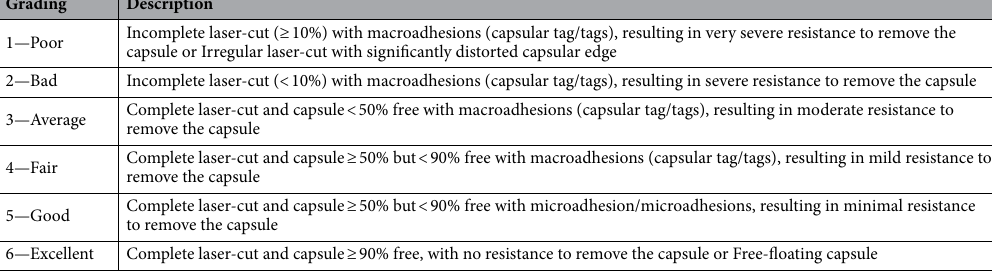
Table 5. Subjective grading of the quality of